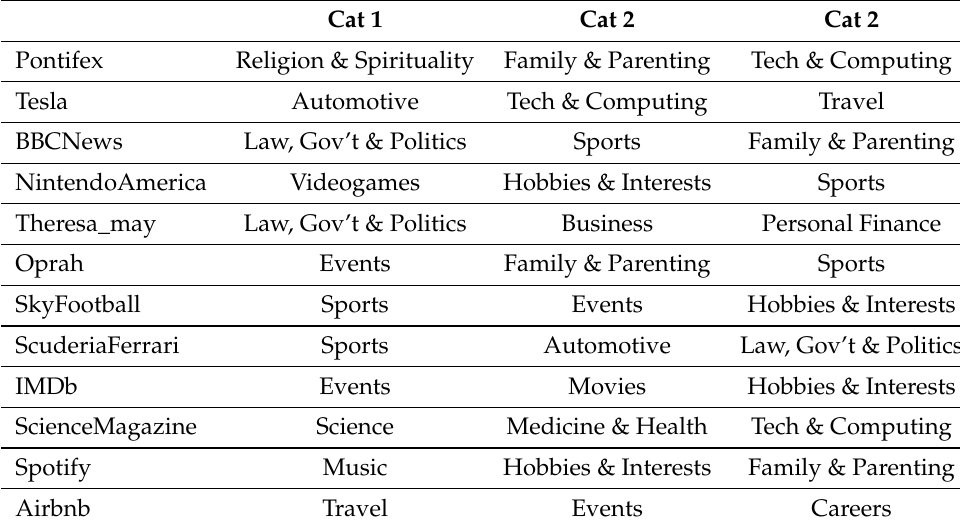
Table 6. NMF evaluation with data from real Twitter profiles.